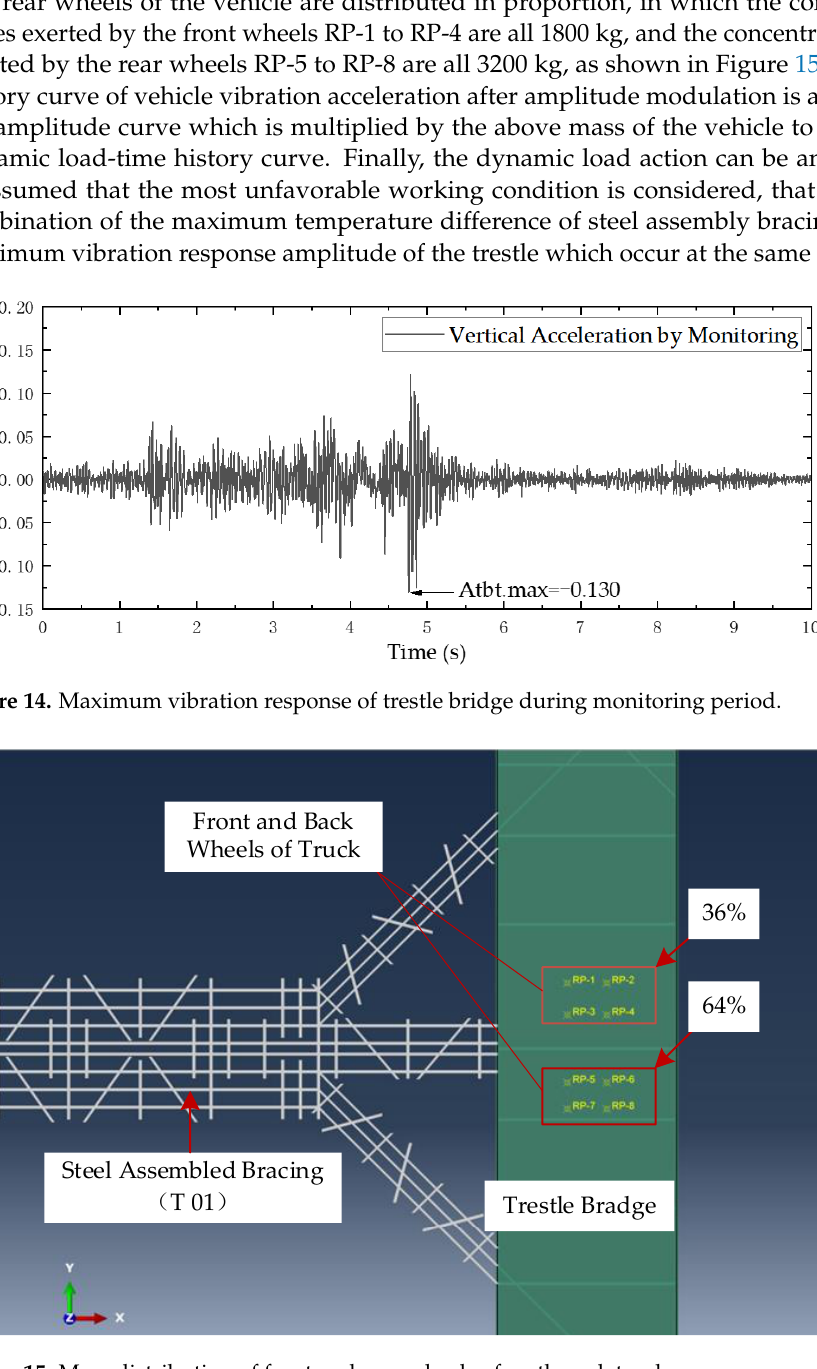
Figure 15. Mass distribution of front and rear wheels of earthwork trucks.